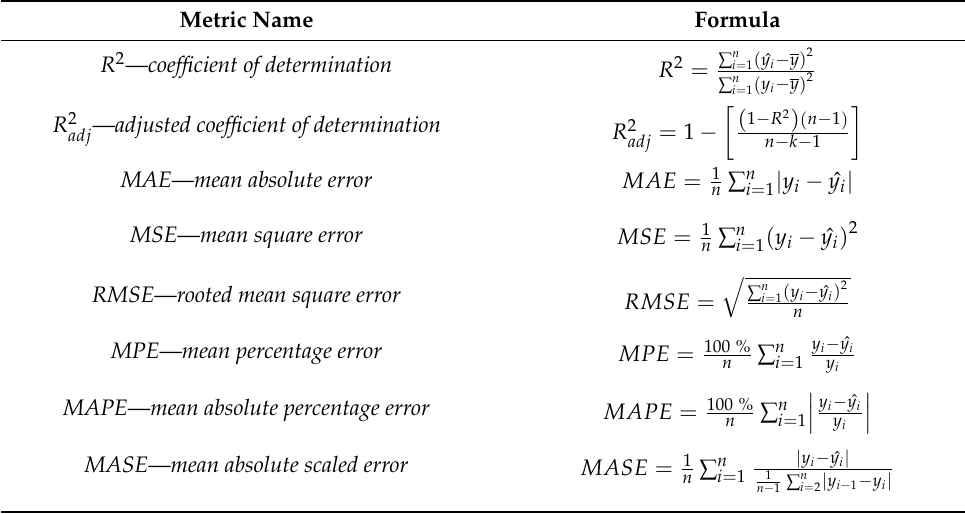
Table 1. Most common evaluation metrics for forecasting/regression